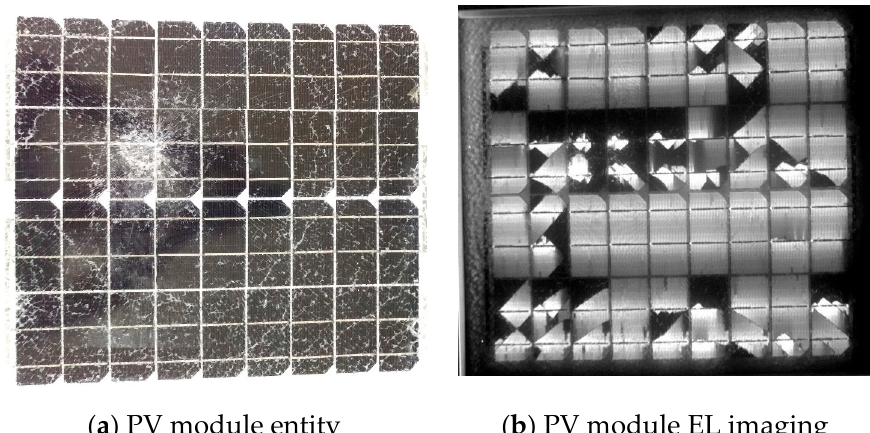
Figure 6. Extensively damaged of the built PV module.